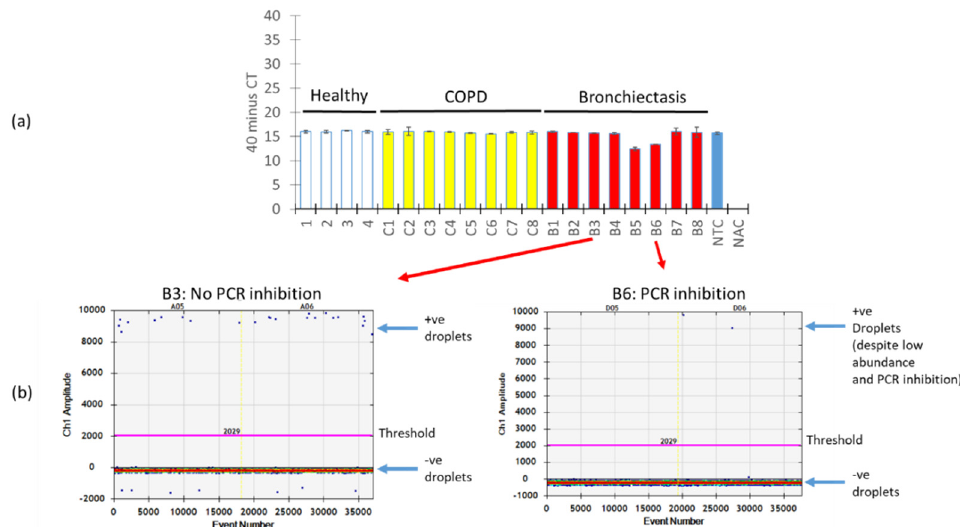
Figure 5. ddPCR is resistant to PCR inhibition. ( a ) Respiratory specimens were “spiked” with an internal positive control and subjected to qPCR illustrating various degrees of PCR inhibition most prominent in specimens B5 and B6. ( b ) One-dimensional amplitude plot from ddPCR illustrating the gating of positive and negative populations (indicated by arrows) that permit an absolute quantification of A. fumigatus despite the presence of PCR inhibitors. Thresholds are indicated by a pink line separating positive and negative fractions from ddPCR. + ve: positive, − ve: negative, NTC: no template control, NAC: no amplification control, qPCR: quantitative polymerase chain reaction, ddPCR: droplet digital PCR, COPD: chronic obstructive pulmonary disease, B: bronchiectasis.